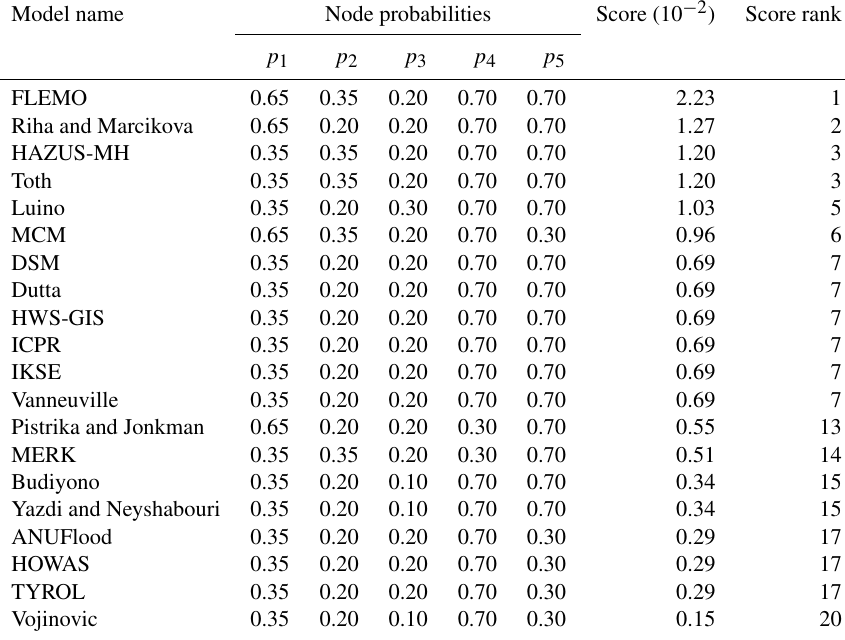
Table 6. Model scores for the Caldogno application